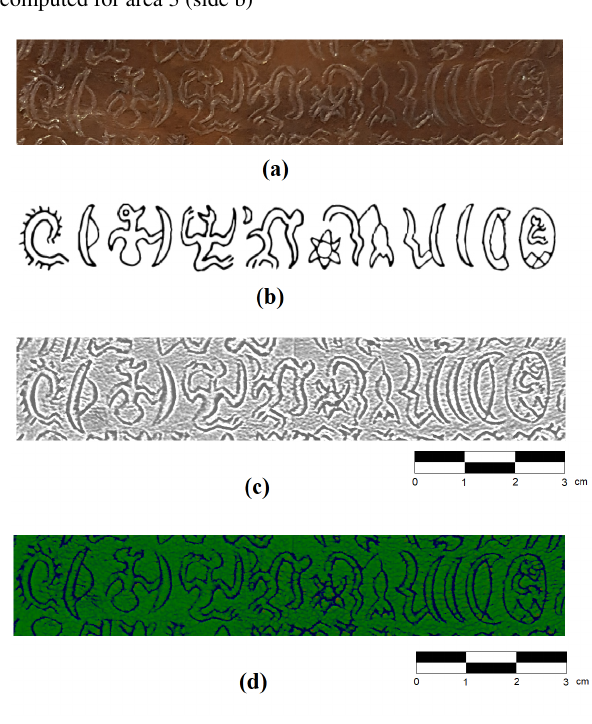
Figure 7: The Mamari tablet, side a, line 7, from glyph 19 (059) to glyph 33 (152): (a) color image; (b) normalized drawing from (Barthel, 1958); (c) 3D model rendered through